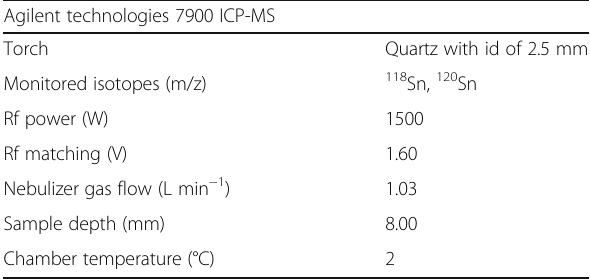
Table 2 ICP-MS operating condition for tin-silica nanoparticles